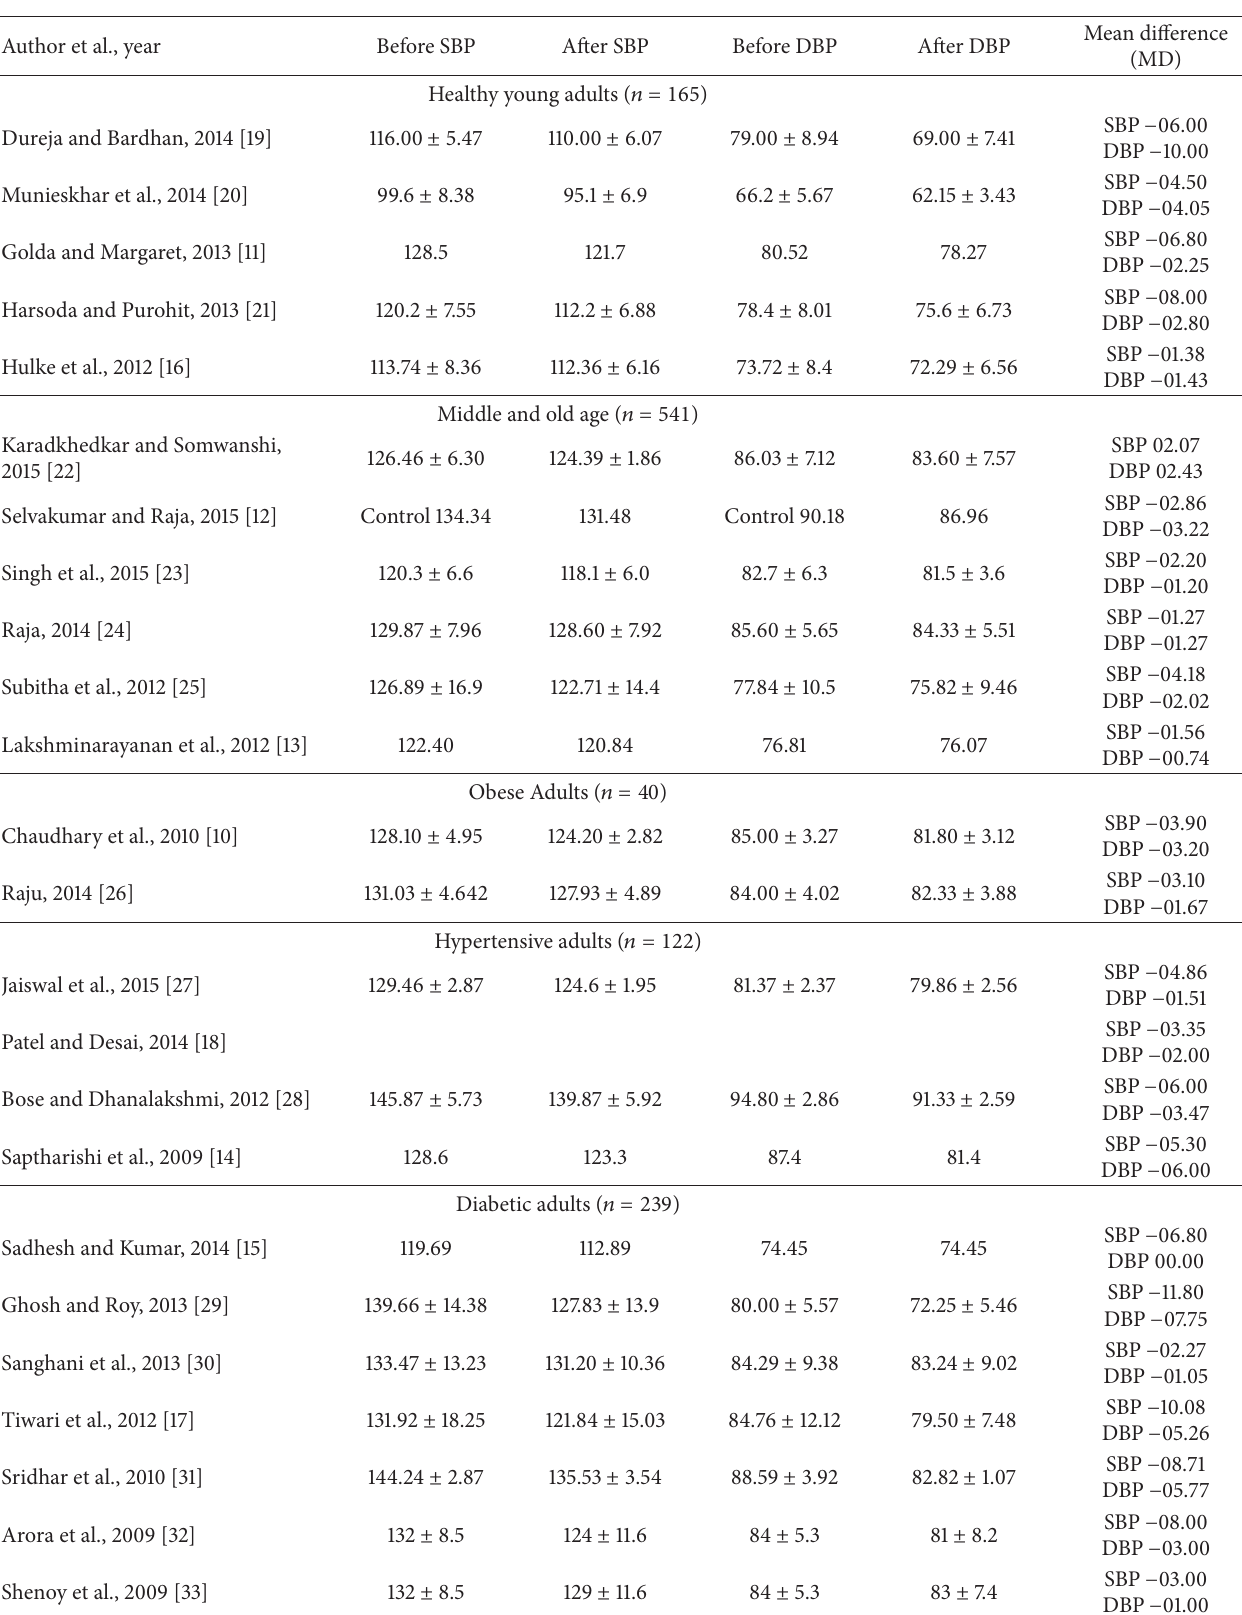
Table 2: Effect of aerobic exercise training on blood pressure in